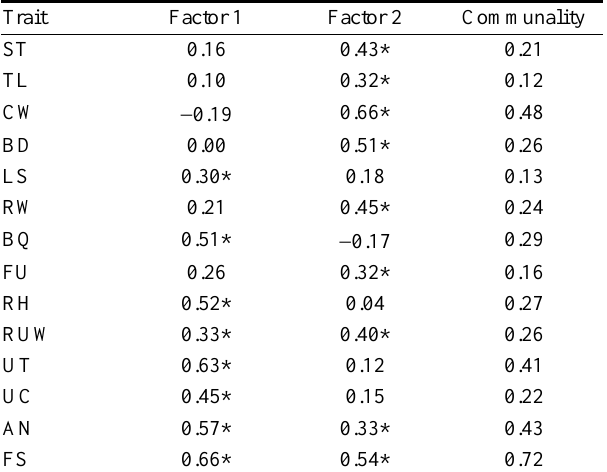
Table 4. Estimates of factor weights for linear type traits using varimax rotation